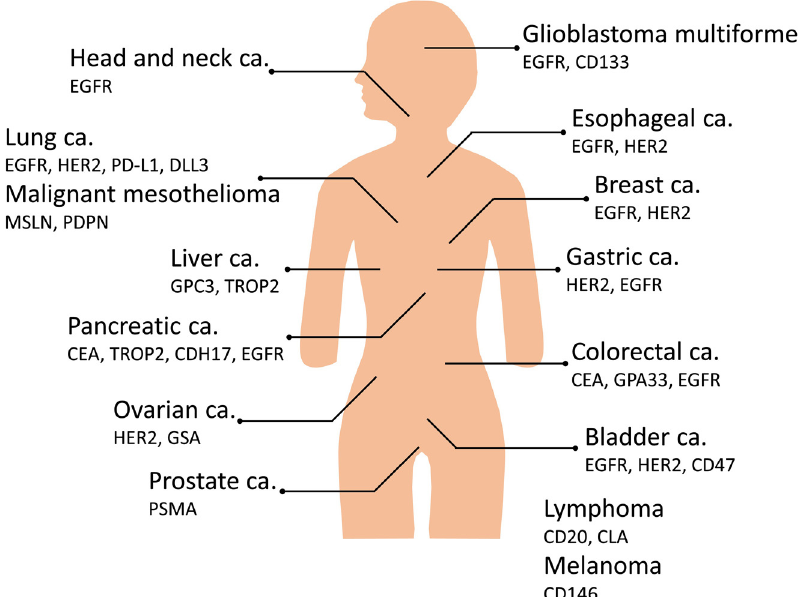
Figure 3: Various cancers and promising targets for